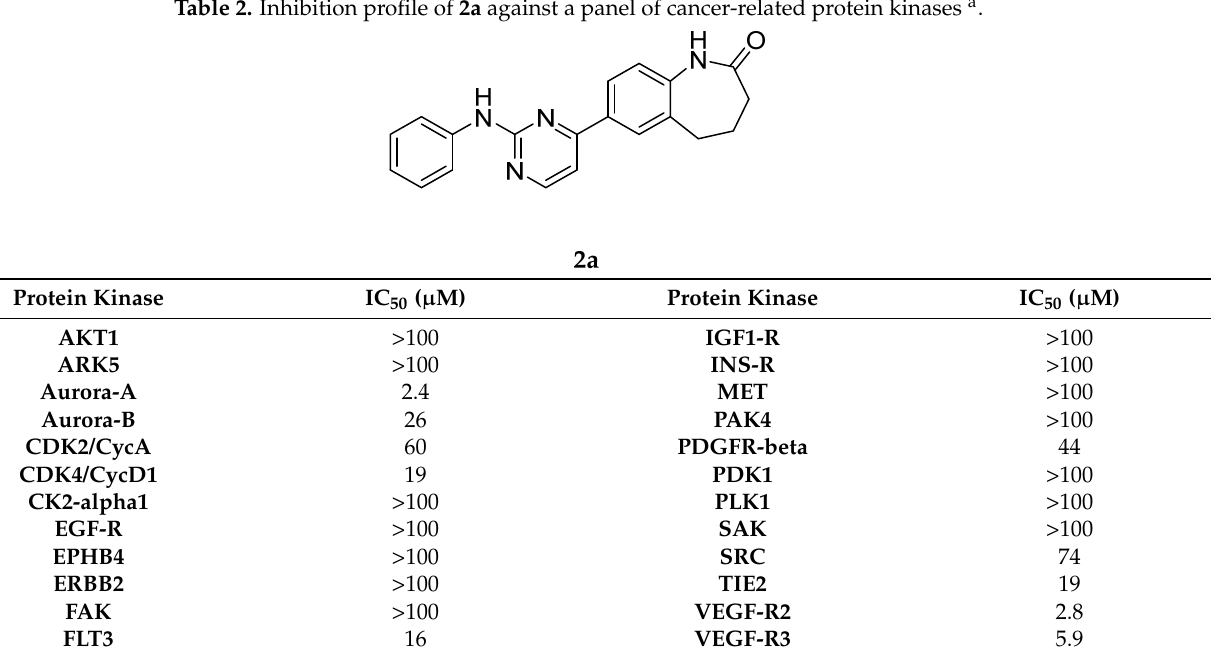
Table 2. Inhibition profile of 2a against a panel of cancer-related protein kinases a.